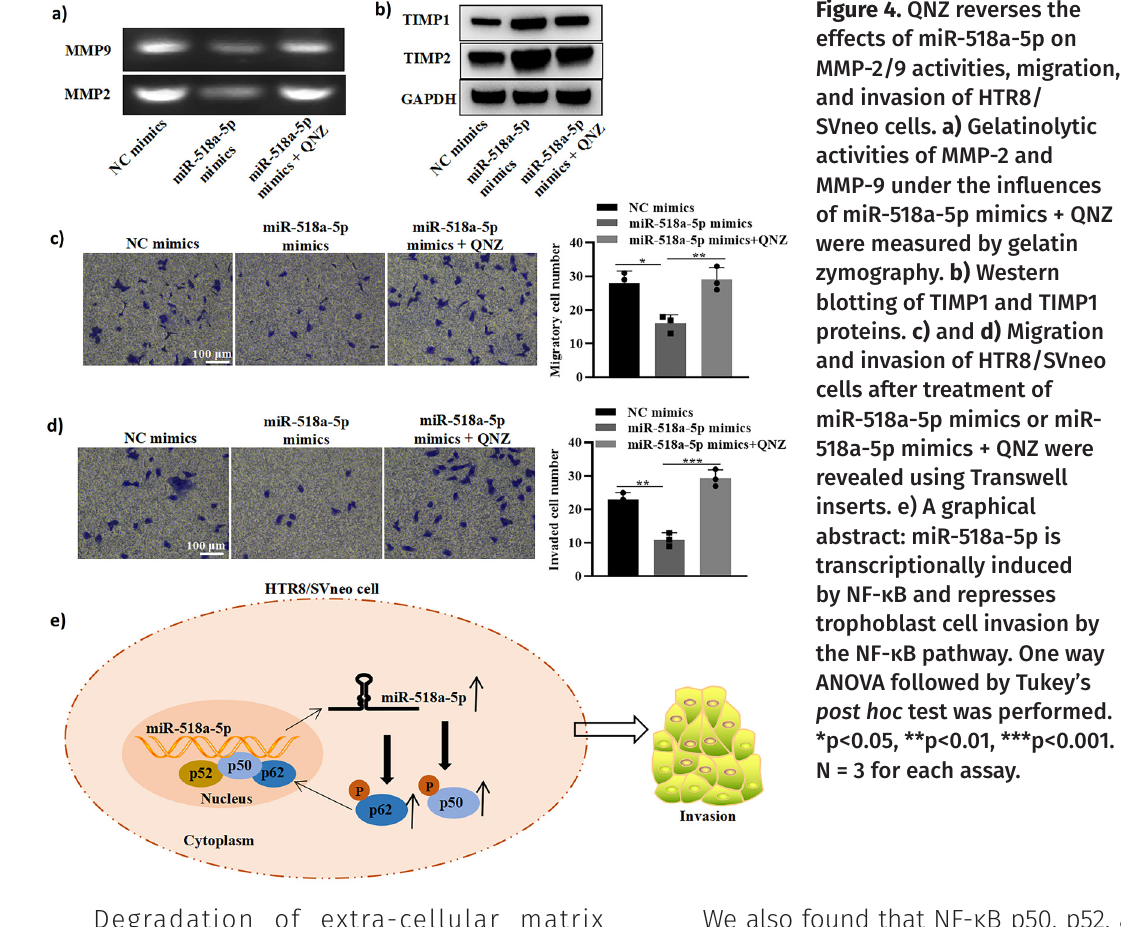
Figure 4. QNZ reverses the effects of miR-518a-5p on MMP-2/9 activities, migration, and invasion of HTR8/ SVneo cells . a) Gelatinolytic activities of MMP-2 and MMP-9 under the influences of miR-518a-5p mimics + QNZ were measured by gelatin zymography. b) Western blotting of TIMP1 and TIMP1 proteins. c) and d) Migration and invasion of HTR8/SVneo cells after treatment of miR-518a-5p mimics or miR- 518a-5p mimics + QNZ were revealed using